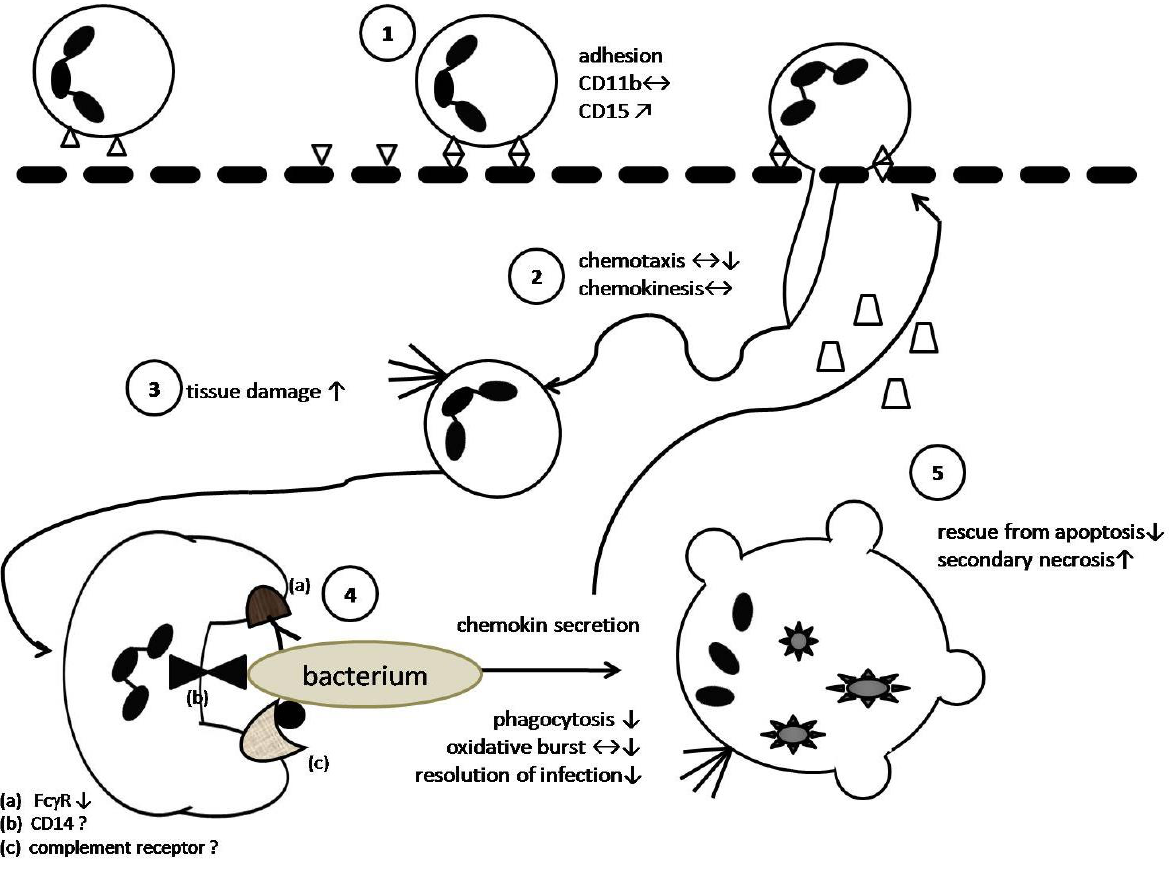
FIGURE 1. Main functional changes of PMN of the elderly. (1) Adhesion of PMN to endothelium and initial extravasation into tissues is constant or even slightly increased, probably due to slightly increased expression of CD11b and CD15. (2) Chemotaxis seems to be compromised by aging, while chemokinesis remains constant[73]. This reduces the efficiency of migration to the site of infection. (3) During migration through the tissue, PMN secrete proteases such as elastase from their granules. The reduction of chemotaxis would cause increased exposure to those proteases, consequently damaging healthy tissue. (4) Phagocytosis of microbes and subsequent killing by oxidative burst are probably reduced with age. This is partly due to decreased expression of Fc  receptors, disturbed response to priming agents, and changes in underlying signaling pathways. The high rate of apoptotic PMN often cannot be cleared by macrophages, delaying the resolution of infection. (5) The impaired rescue from apoptosis described for PMN of aged donors leads to an increase of secondary necrosis and the leakage of intracellular proteins to the extracellular space and finally to inflammation. Each of those changes contributes to the reduced ability of the elderly to clear bacterial infections and to resolve inflammation. (Modified and adapted from Butcher et